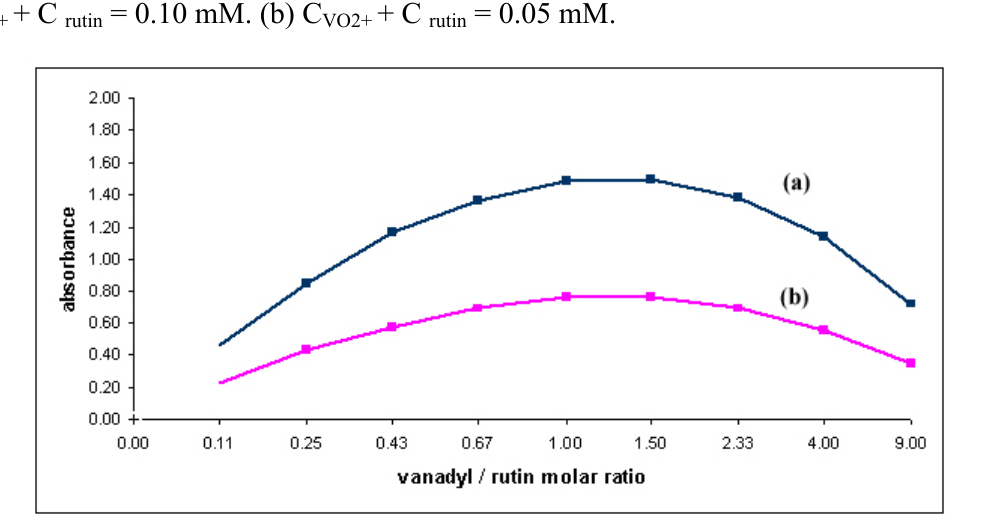
Figure 8. Absorbance versus rutin concentration (C